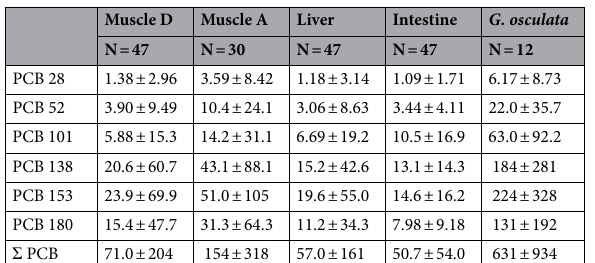
Muscle D Muscle A Liver Intestine G.